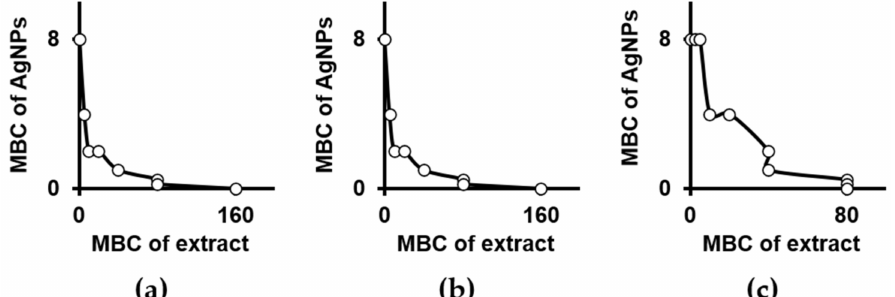
Figure 1. Bactericidal activity of silver nanoparticles combined with extracts from D. muscipula ( a ), Drosera binata ( b ) and Drosera gigantea ( c ) used towards Pseudomonas aeruginosa ATCC 27853. Following units apply for axes: µ g Ag mL − 1 (MBC of AgNPs) and µ g FW mL − 1 (MBC of extract).